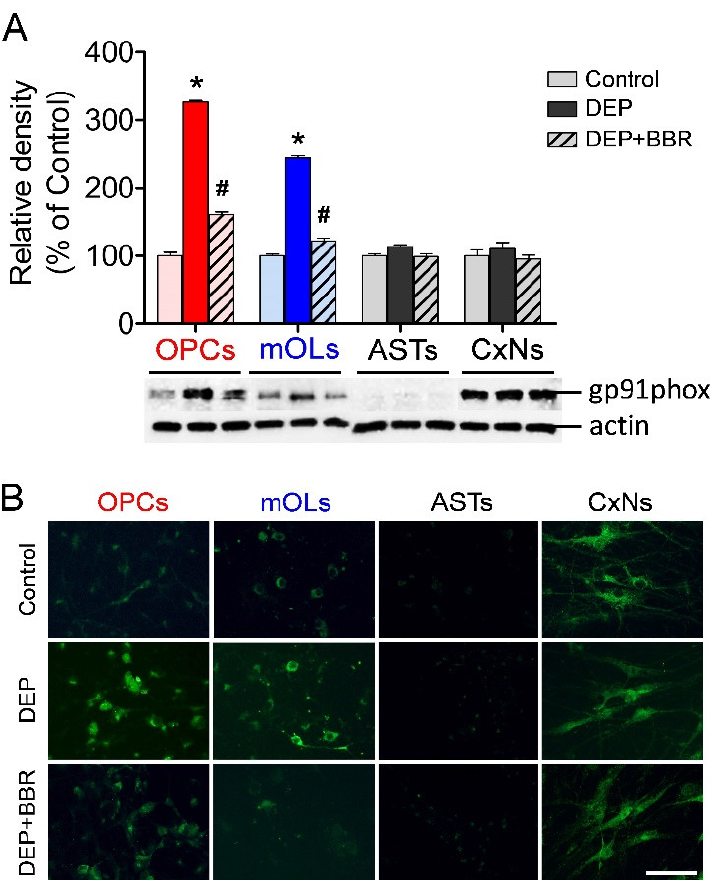
Figure 3. Expression of gp91phox (NOX2) in brain cells after exposure to ultrafine DEPs. ( A ) Quan- titative analysis. The gp91phox expressions in OPCs and mOLs exposed to ultrafine DEPs (200 µ g/mL) are significantly higher than those of each control group. However, BBR treatment significantly suppresses the gp91phox expressions in OPCs and mOLs exposed to ultrafine DEPs. There are no differences in the gp91phox expressions of astrocytes and cortical neurons in each group. ( B ) Immunofluorescence. The gp91phox expressions in OPCs and mOLs exposed to ultrafine DEPs are markedly increased compared with those of each control group. However, BBR treatment suppresses the gp91phox expressions in OPCs and mOLs exposed to ultrafine DEPs. Changes in gp91phox expressions are not observed in astrocytes and cortical neurons in each group. ASTs = astrocytes, CxNs = cortical neurons. * p < 0.05 for DEP group vs. control, # p < 0.05 for DEP + BBR group vs. DEP group. Scale bar = 200 μm.